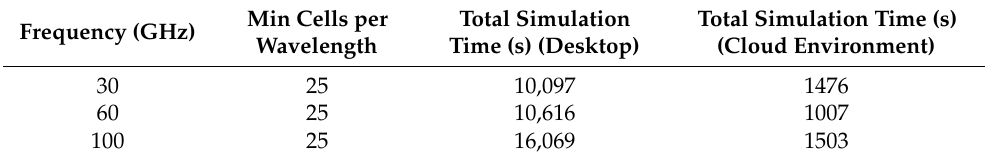
Table 5. Thecomparisonofcomputationtimeusinganordinarydesktopcomputerandacloudenvironment. Frequency